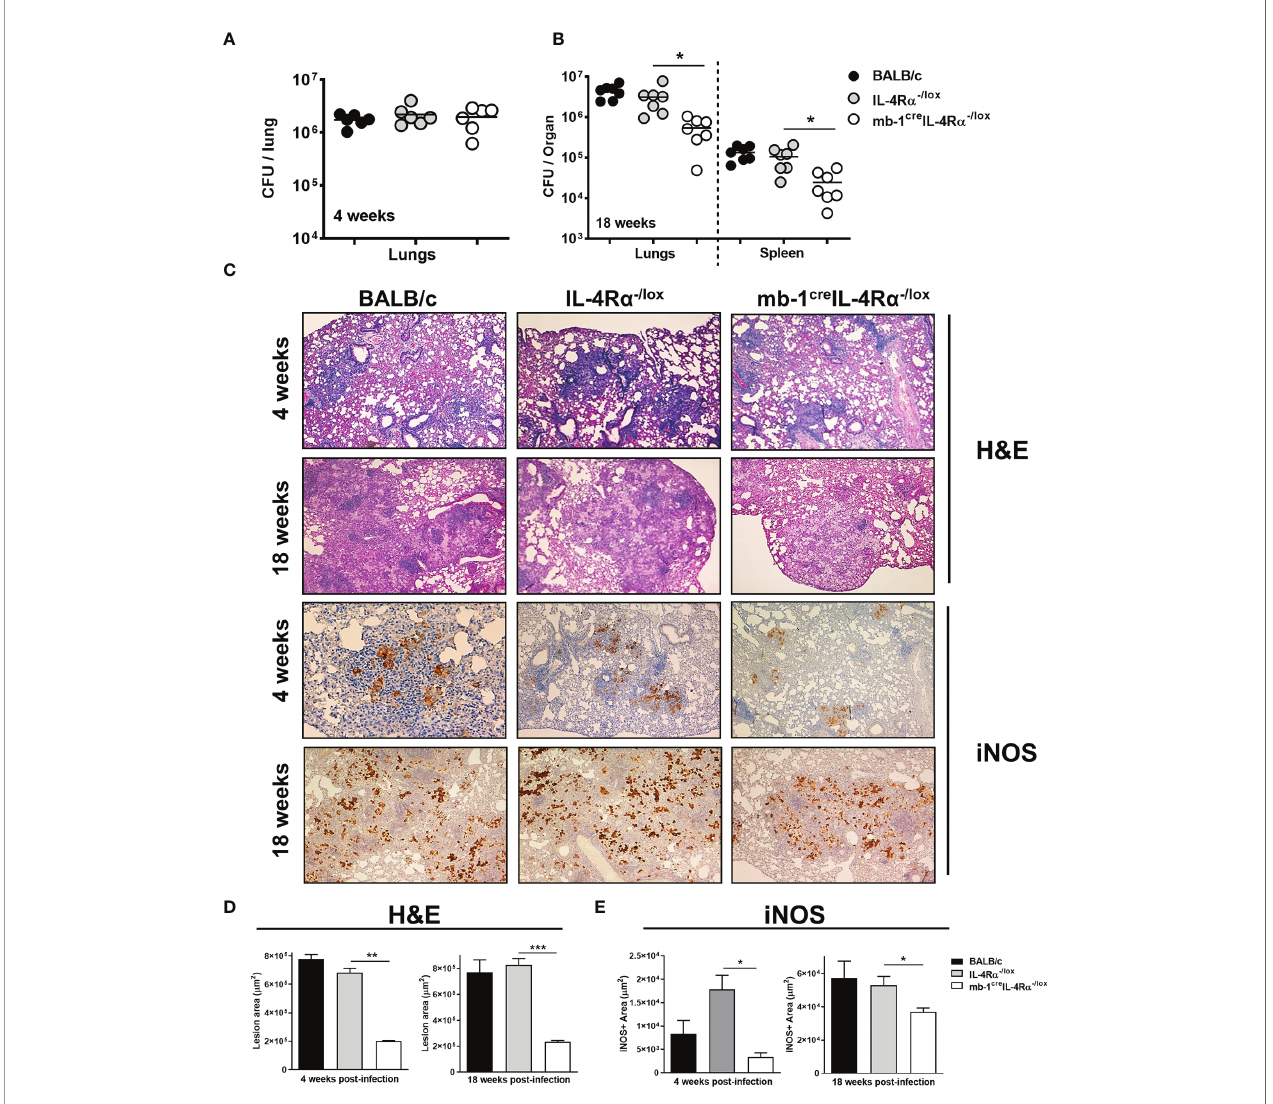
FIGURE 1 | Deletion of IL-4R a on B cells decreased mycobacterial burdens and lung pathology during Mtb infection. Wild-type (BALB/c), littermate controls (IL- 4R a -/lox ) and B cell-speci fi c IL-4R a de fi cient mice (mb-1 cre IL-4R a -/lox ) were infected via aerosol inhalation with a dose of 200 CFU H37Rv. (A) Mycobacterial burdens in the lungs at 4 weeks post-infection. (B) Lung mycobacterial burden and dissemination in the spleen at 18 weeks post-infection. (C) Representative histology images of lung sections stained with H&E and iNOS at 4 and 18 weeks post-infection (Original magni fi cation: 10X). (D, E) Quanti fi cation of lesion area and iNOS positive area in the lungs at 4 and 18 weeks post-infection. Data are shown as mean ± SEM of n = 6 mice/group and representative of two independent experiments, analysed by unpaired, student ’ s t-test versus littermate control, *p < 0.05, **p < 0.01 and ***p <